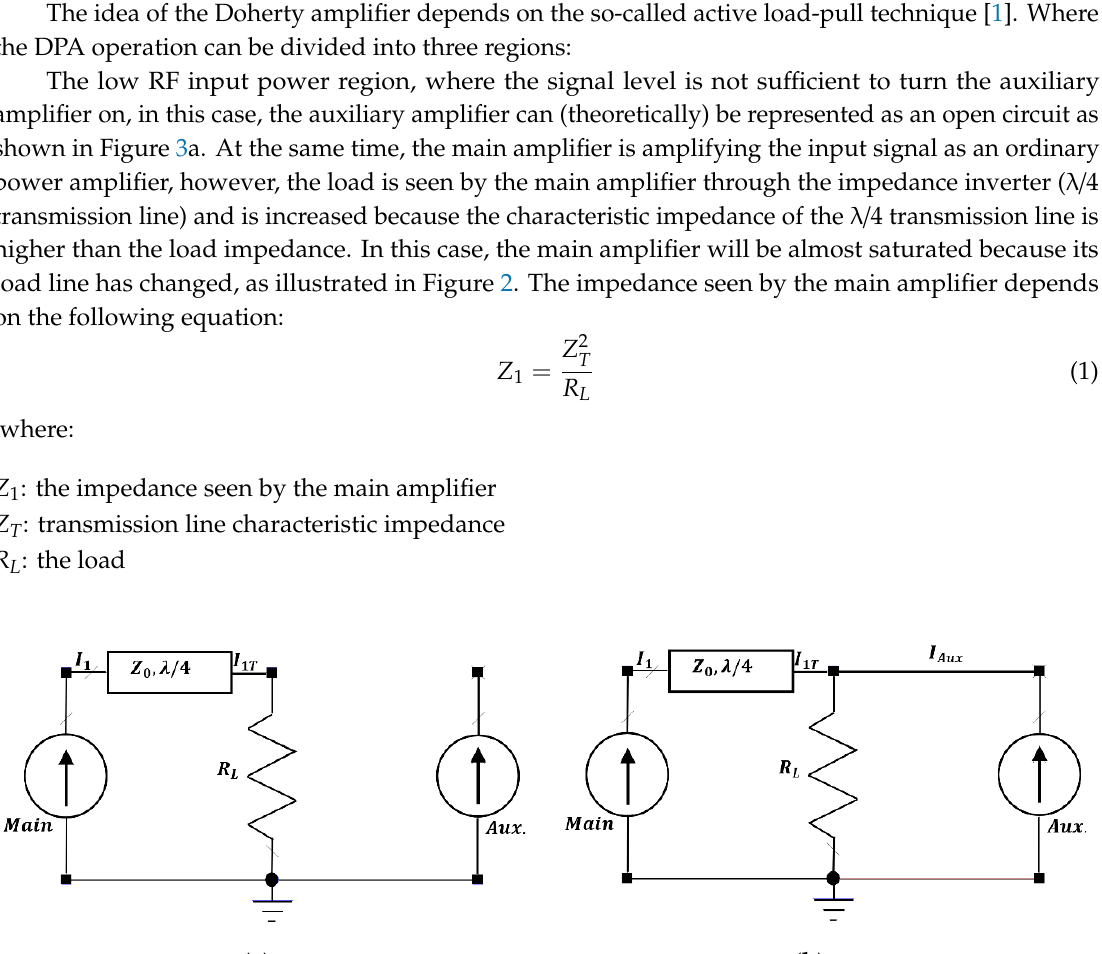
Figure 3. Doherty equivalent circuit diagram ( a ) at low power region and ( b ) at medium and high-power region.